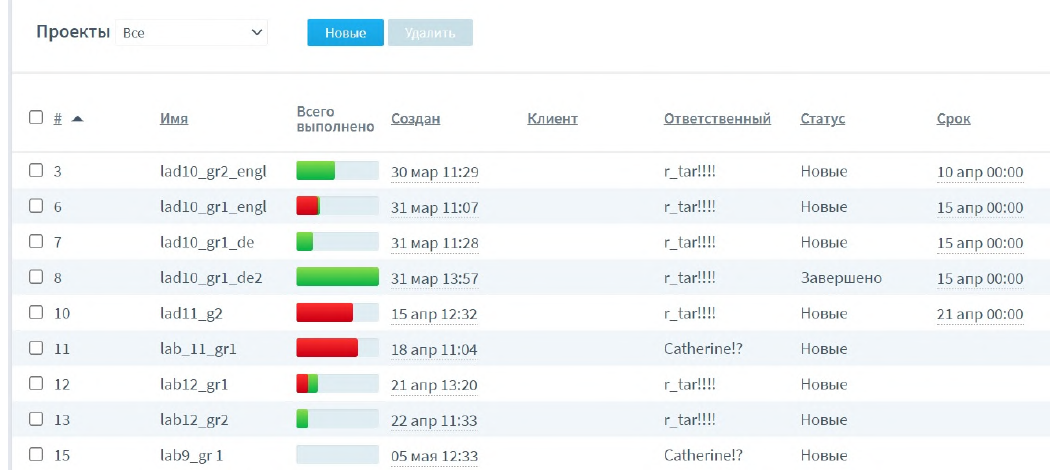
Figure 4: Monitoring the status of projects and tasks in the Memsource system.